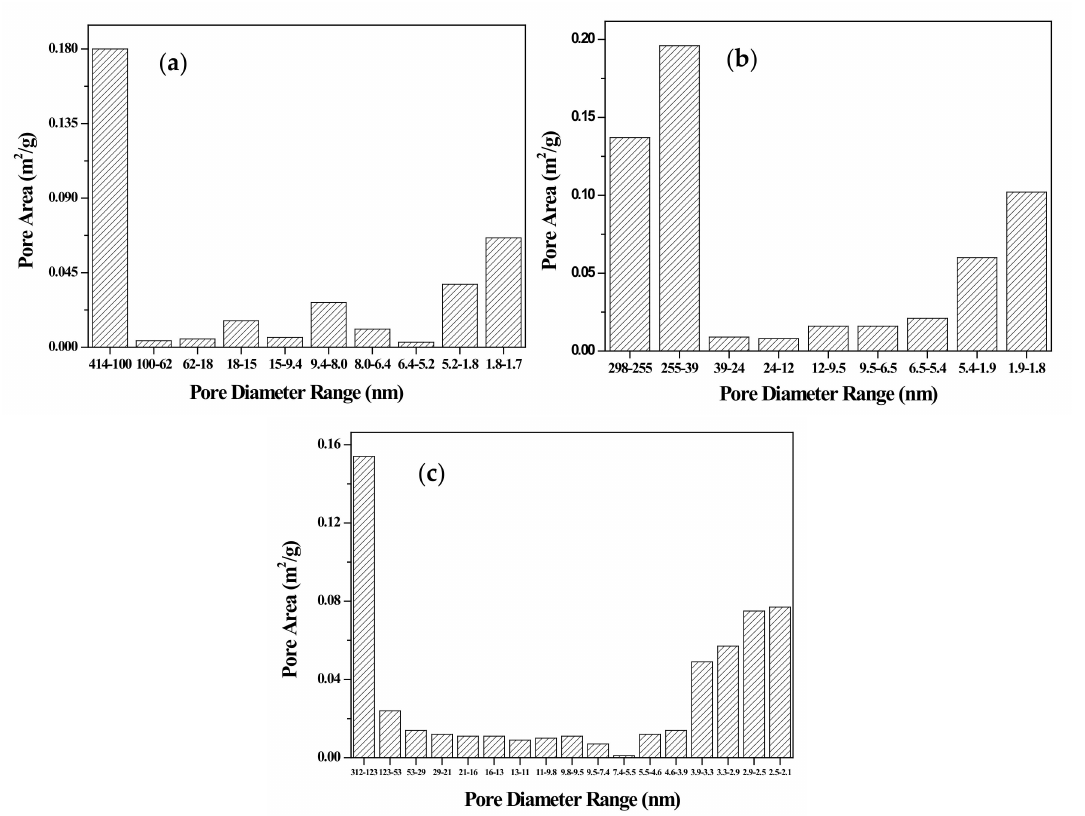
Figure 4. Pore area distribution of di ff erent pore size ranges on the adsorbent: ( a ) rice bran, ( b ) rice bran / SnO 2 , and ( c ) rice bran / SnO 2 / Fe 3 O 4